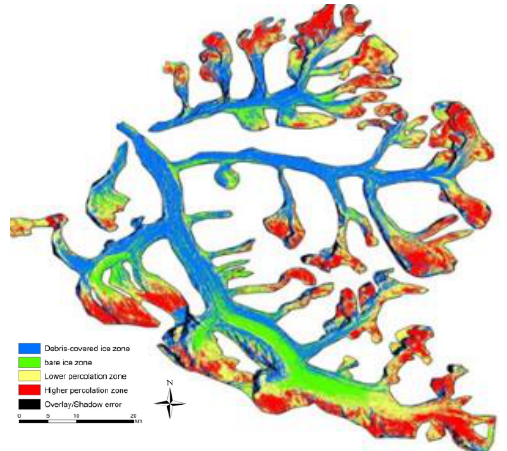
Figure 18: SAR based glacier facies of Gangotri glacier